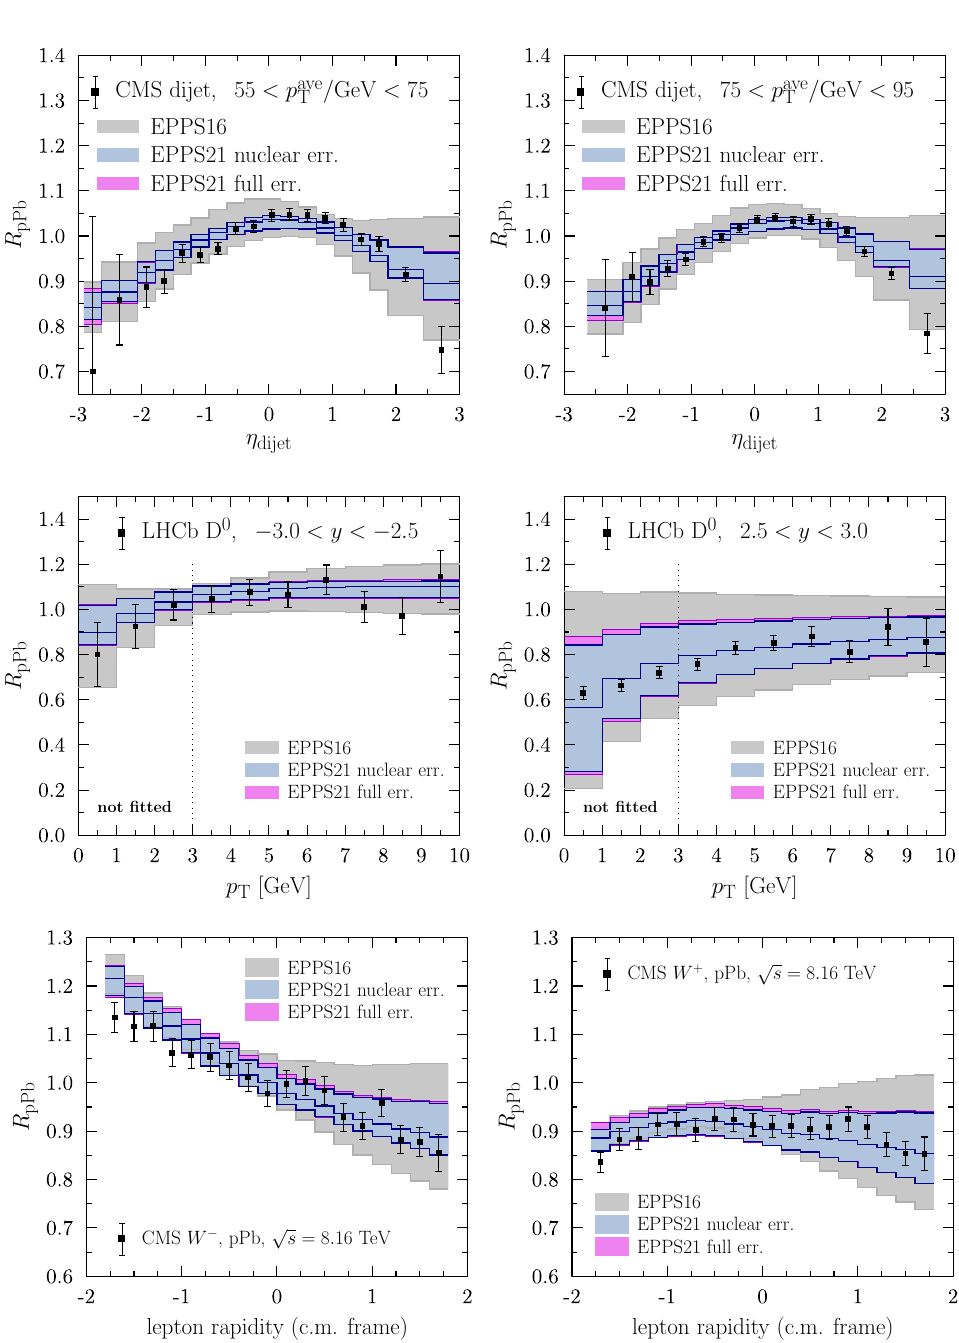
Figure 2: A sample of the new LHC data included in the EPPS21 analysis: The CMS measurement of dijet nuclear modifications [ 4 ] in the two lowest p LHCb measurement of the nuclear modifications in D 0 production [ 5 ] in a backward and forward rapidity bin (middle) and the mixed-energy nuclear-modification ratios of the CMS measurements of W ± -production [ 6,10 ]